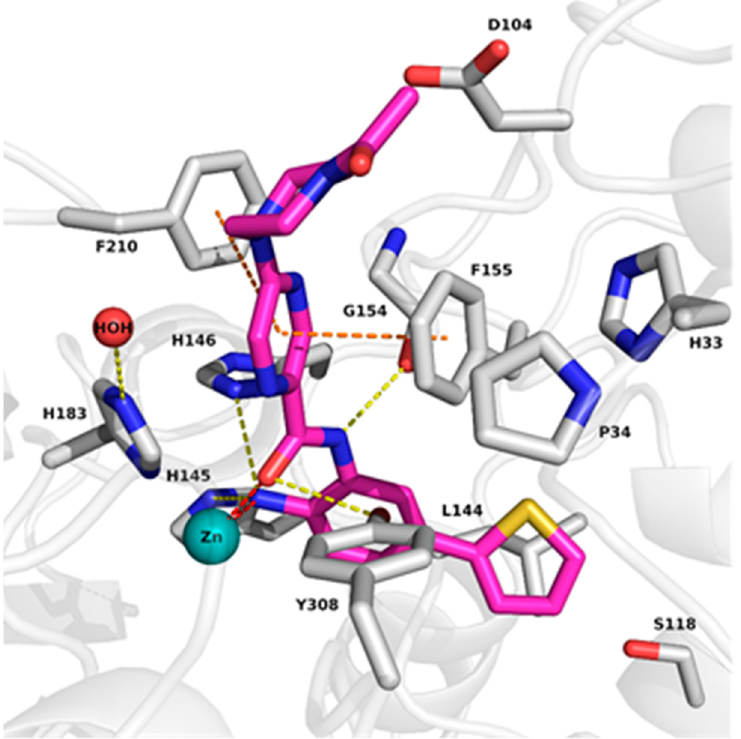
Figure 10. Docking pose of 30c inHDAC2. The carbons of shown protein amino acid residues are white. Zinc ion is shown as cyan sphere, water molecule as red sphere, the ligand is shown in stick representation with magenta-colored carbon atoms. Zinc coordination is shown as red dashed lines, hydrogen bonds as yellow dashed lines and aromatic interactions as orange dashed lines.